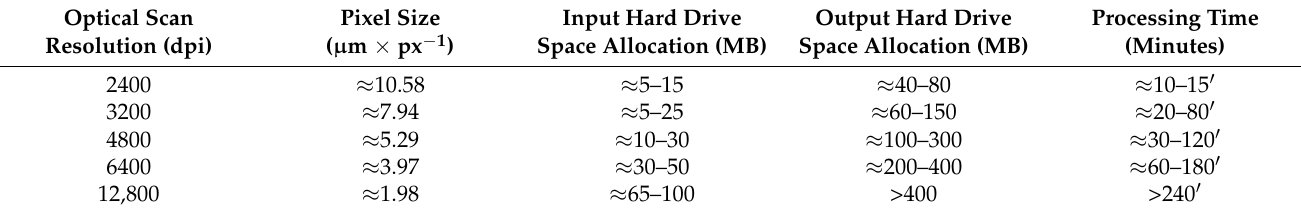
Table 1. Hard drive space allocation and processing time used by the Micro-Fabric Analyzer at different image resolutions. Optical